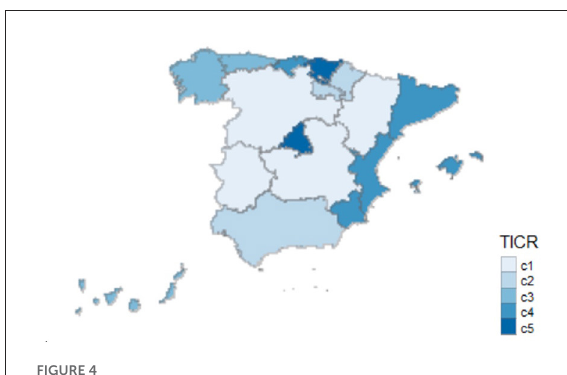
FIGURE4 Clusters of the ACS according to the TICR